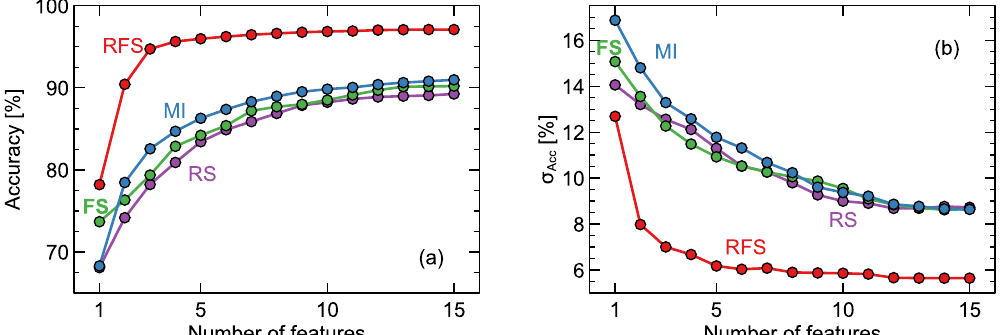
Figure 8. Average accuracy of models versus number of features used for training. Comparison of the recursive forward selection (RFS) method with filter selection methods: Mutual Information (MI), Fisher Score (FS), and ReliefF Score (RS). ( a ) average accuracy, ( b ) standard deviation of accuracy σ Acc . Lines are drawn as a guide for the